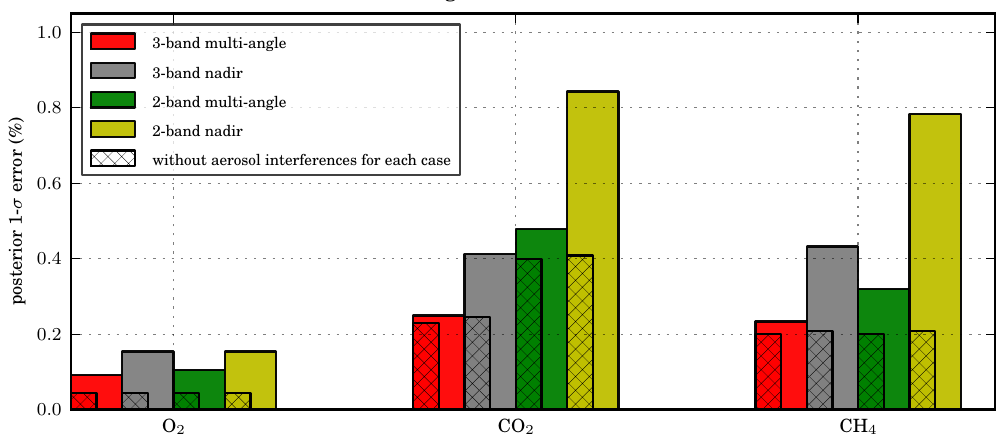
Fig. 10. Posterior error estimates (1 σ ) of trace gas total column amount in %. Winter case (see Table 2), OCO-2 spectral resolutions and SNR=200 for each spectrum was